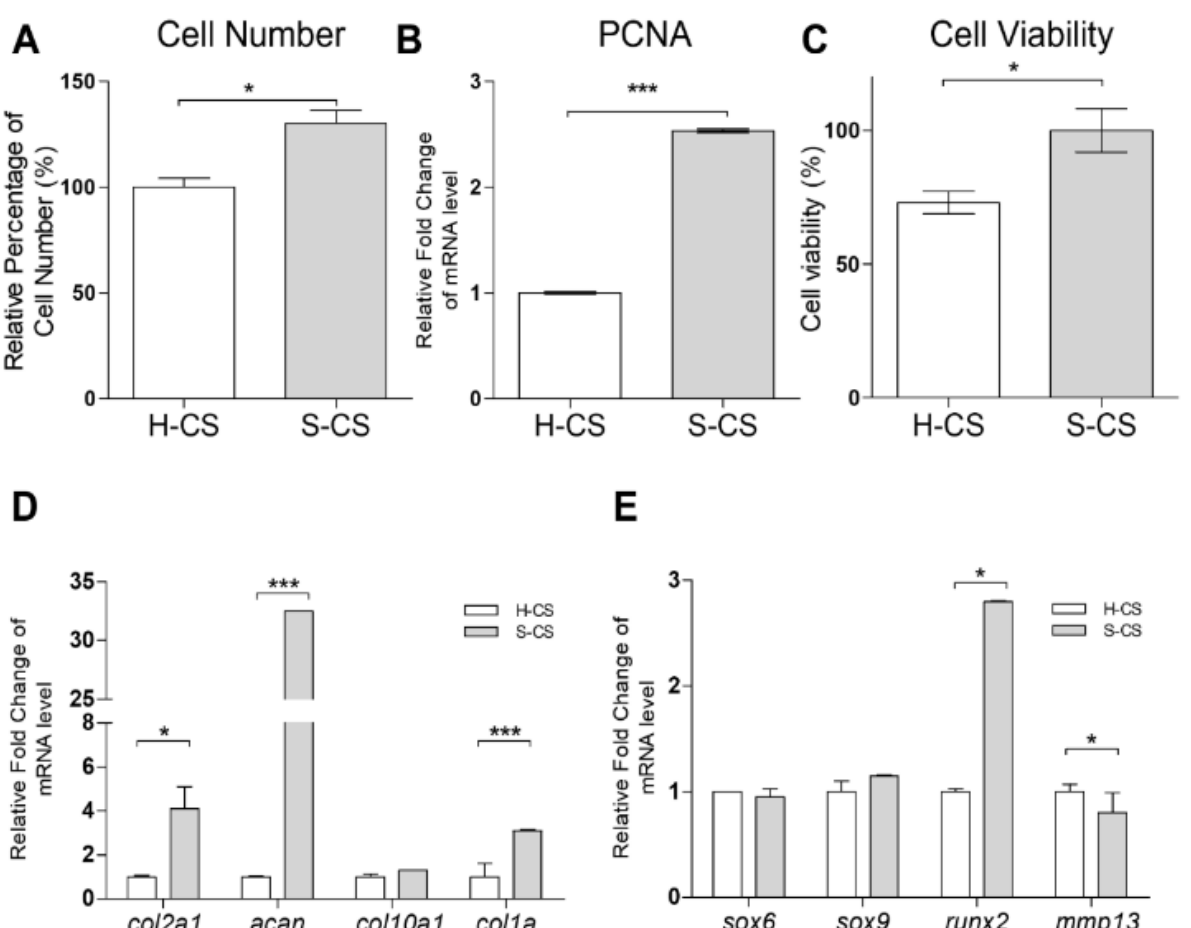
Figure 2. Comparison the cell proliferation, viability, and chondrogenic-related gene expression of heterogeneous chondrocyte sheets (H-CS) and stratified chondrocyte sheets (S-CS). ( A ) Cell proliferation rates of different sheets were determined by counting the cell numbers using a hemacytometer. ( B ) The mRNA expressions of pcna in the H-CS and S-CS were detected by qRT-PCR. ( C ) The cell viability of was detected using an MTT assay * compared with the H-CS group. ( D , E ) The mRNAs of col2a1 , acan , col10a1 , col1a , sox5 , sox6 , sox9 , runx2 , mmp13 , and gapdh of H-CS and S-CS were analyzed by qRT-PCR. The modulation of mRNA expression was expressed relative to the H-CS after normalization to the gapdh signal. (*, p < 0.05, ***, p < 0.001).